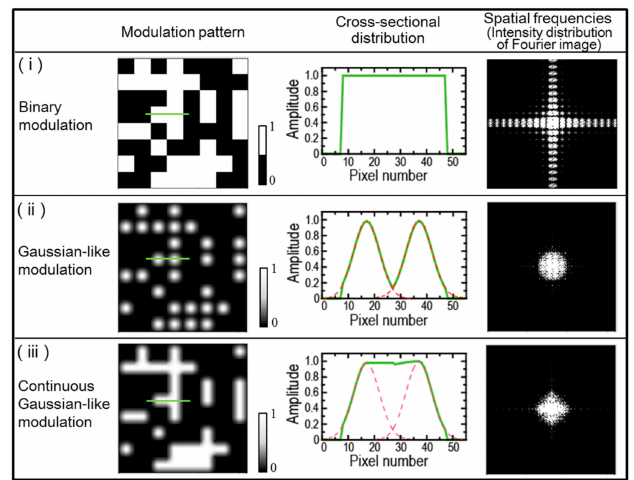
Figure 1. Three types of two-dimensional random modulation